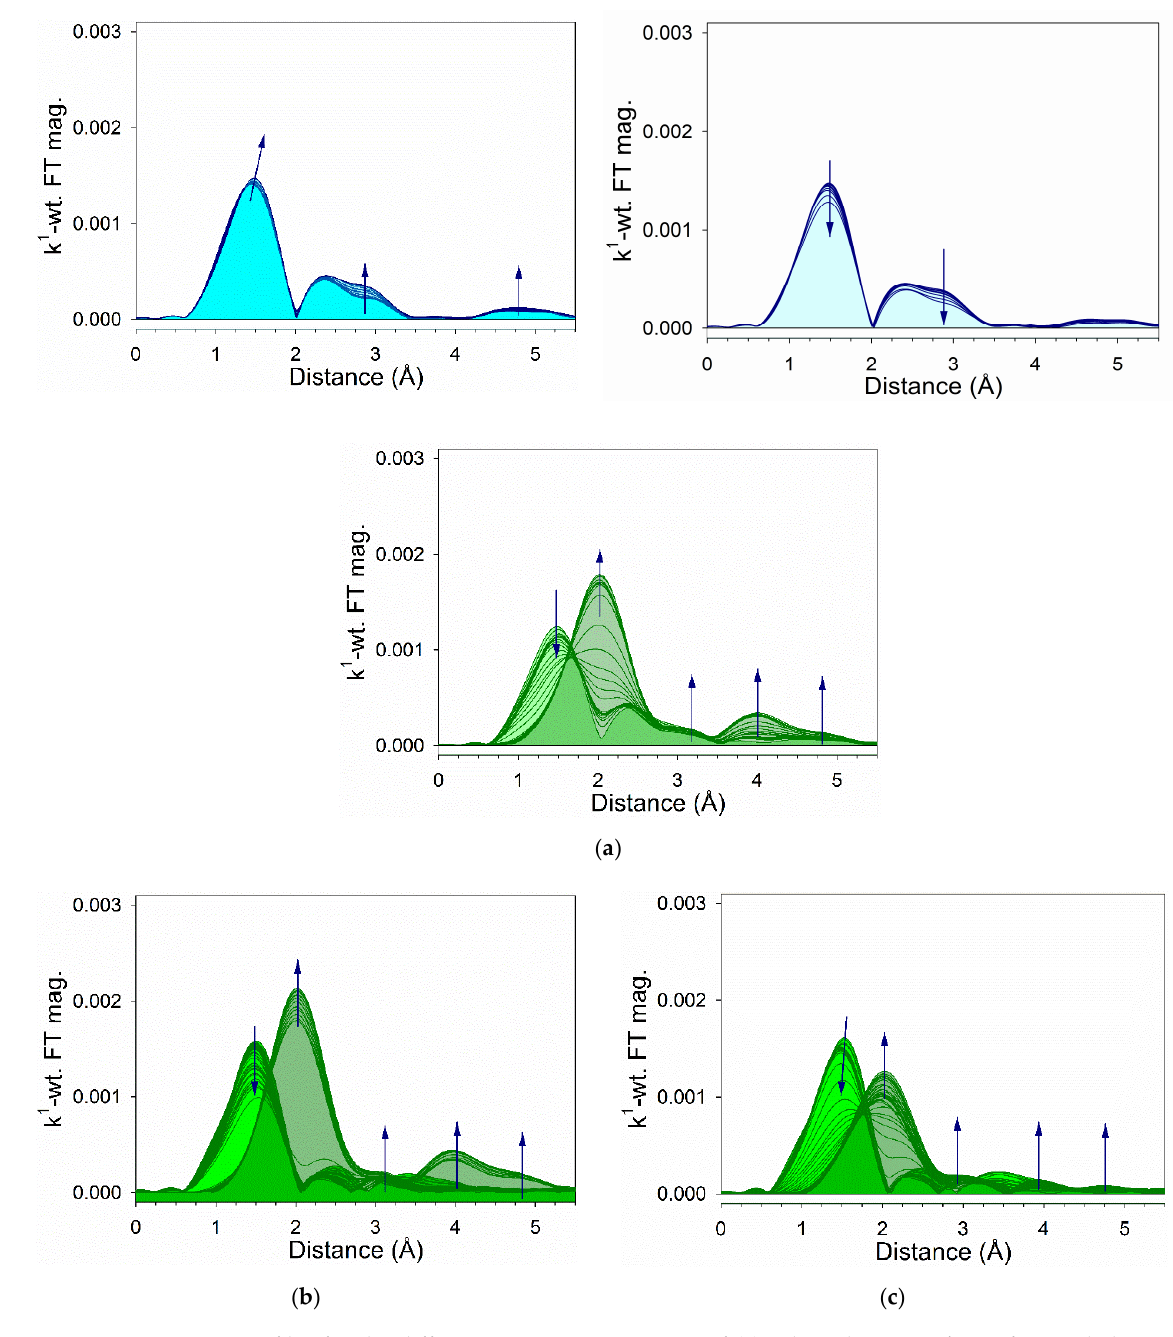
Figure 8. TPR-EXAFS profiles for the different temperature regions of ( a ) calcined 12% Co/SiO 2 from cobalt acetate, ( b ) uncalcined 12% Co/SiO 2 from cobalt acetate, and ( c ) uncalcined 0.5% Pt-12% Co/SiO 2 from cobalt acetate.